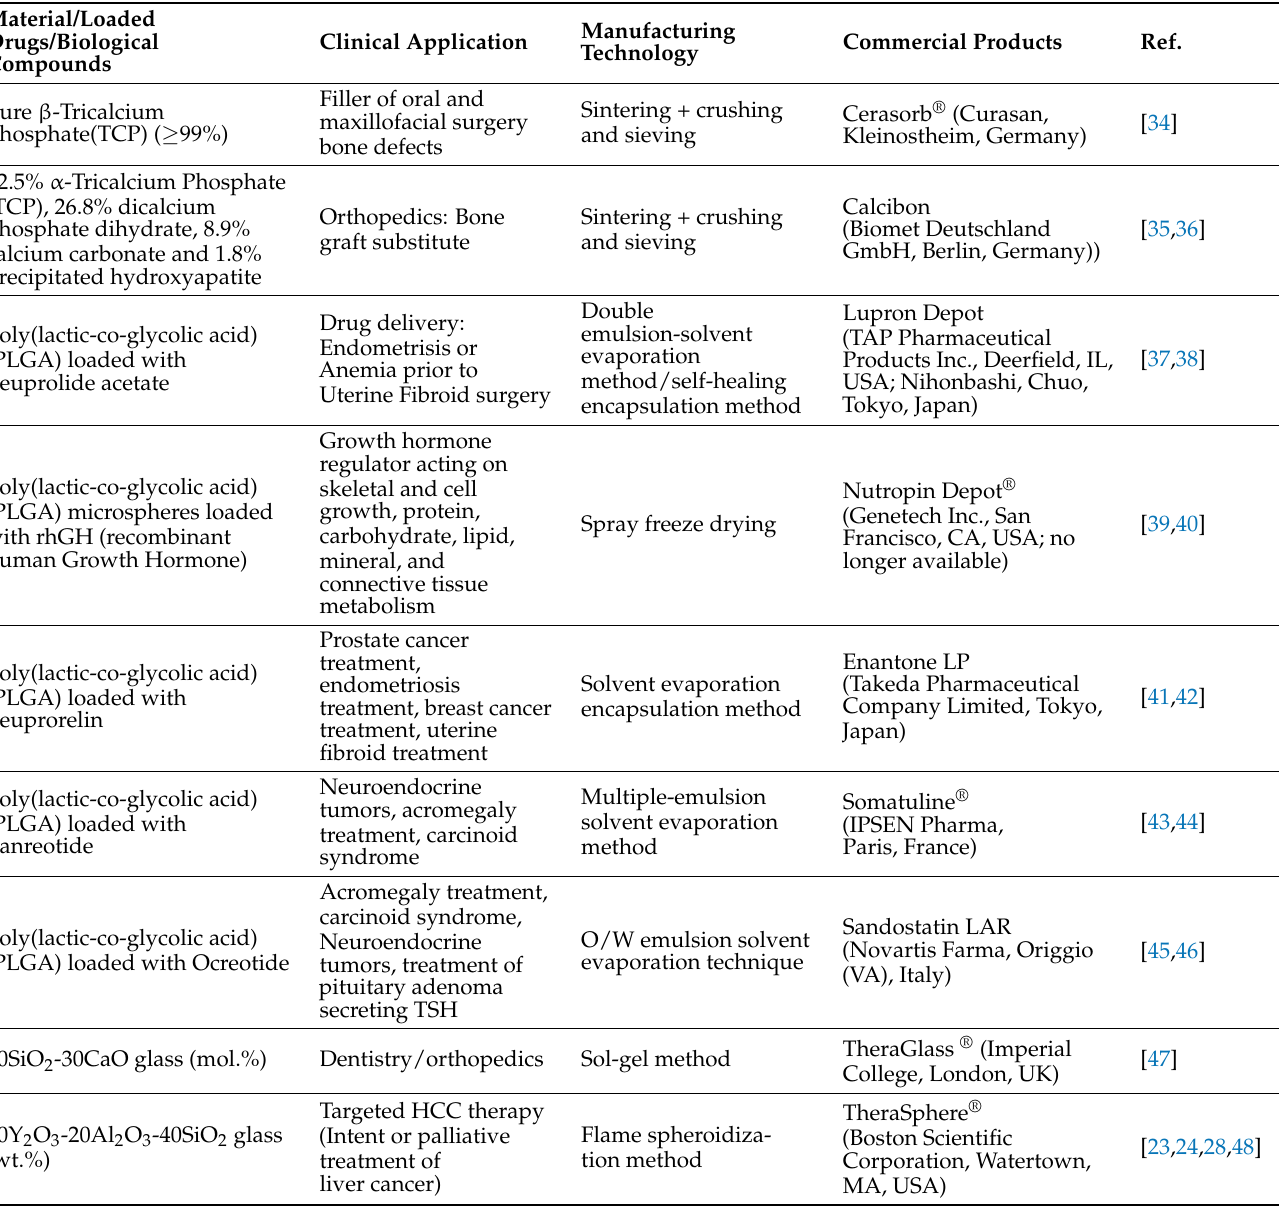
Table 2. Application fields of microsphere technology in biomedicine and related commercial products, where available. Material/Loaded Manufacturing Drugs/Biological Clinical Application Commercial Products Technology Compounds